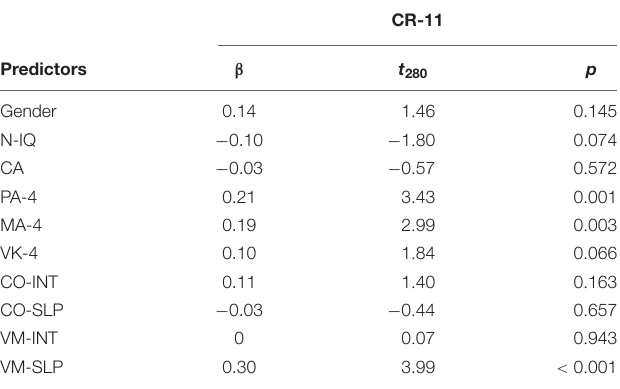
TABLE 2 | Multiple regression analysis for the entire